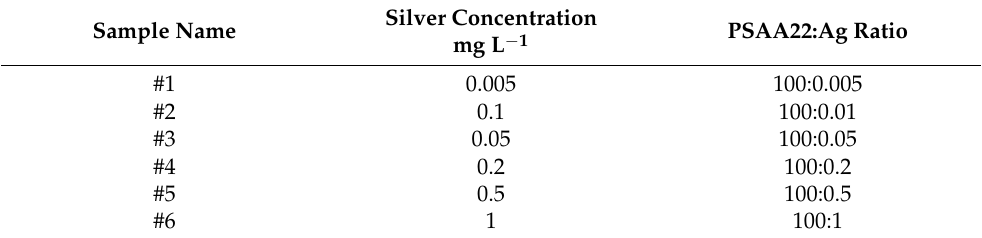
Table 1. Samples of labelled PSAA22, silver concentration and PSAA22:Ag ratio.